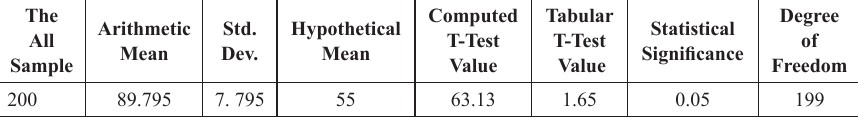
Table 2. The mean and the T-value (questions (correction of 10))